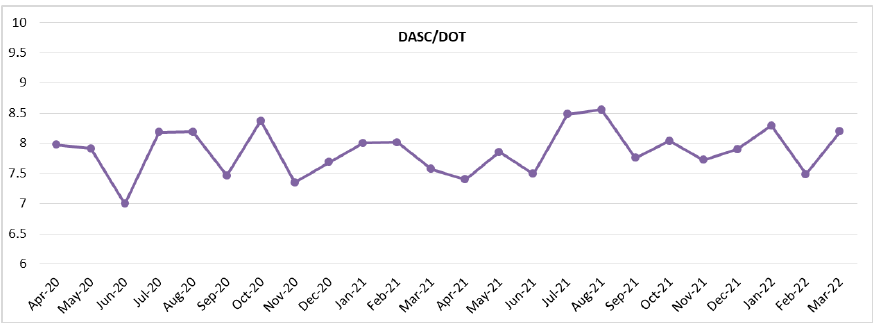
Figure 2. Monthly DOT and DOT/patient trends during this 2-year period. DOT, days of therapy.